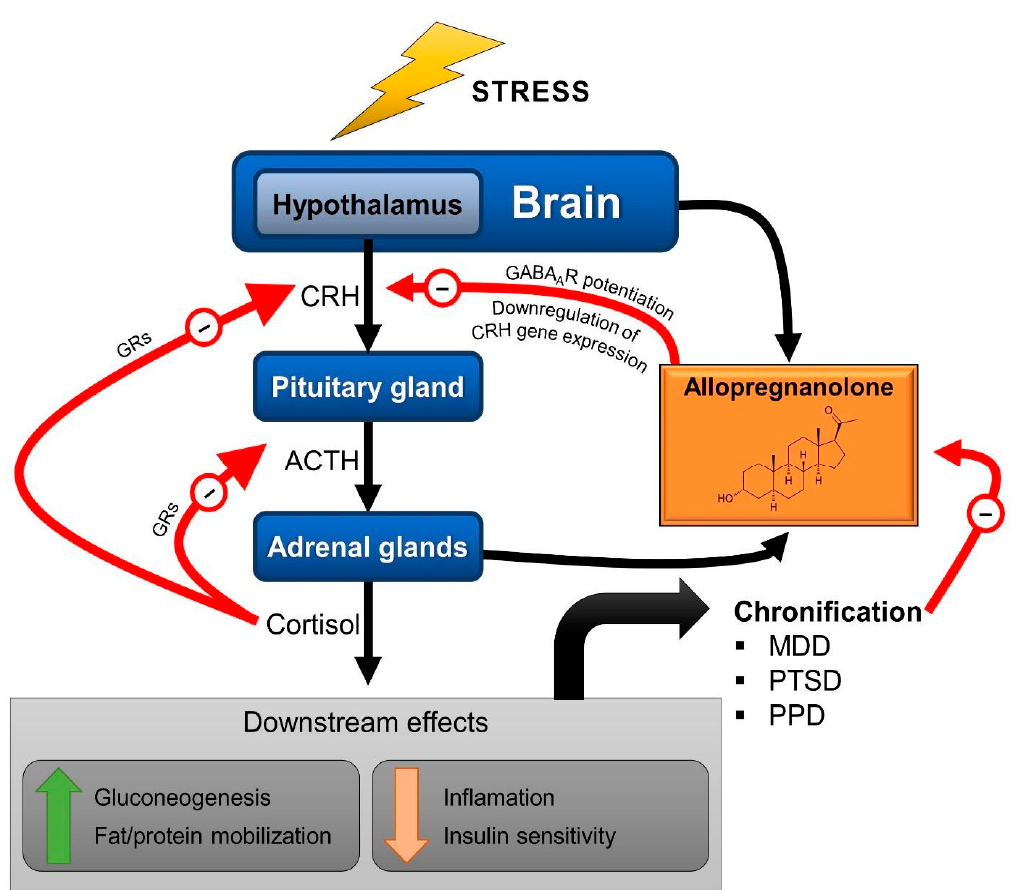
Figure 2. Schematic representation of the HPA axis with the neurosteroid allopregnanolone as a modulator of the stress response. Through positive allosteric modulation of the GABA A receptors (GABA A Rs) present in corticotropin-releasing hormone (CRH) neurons, allopregnanolone participates in the negative feedback that eventually terminates the acute stress response. ACTH: adrenocorticotropic hormone; GRs: glucocorticoid receptors; MDD; major depressive disorder; PTSD: post-traumatic stress disorder; PPD: postpartum depression. Red arrows ( − ) indicate negative feedback.